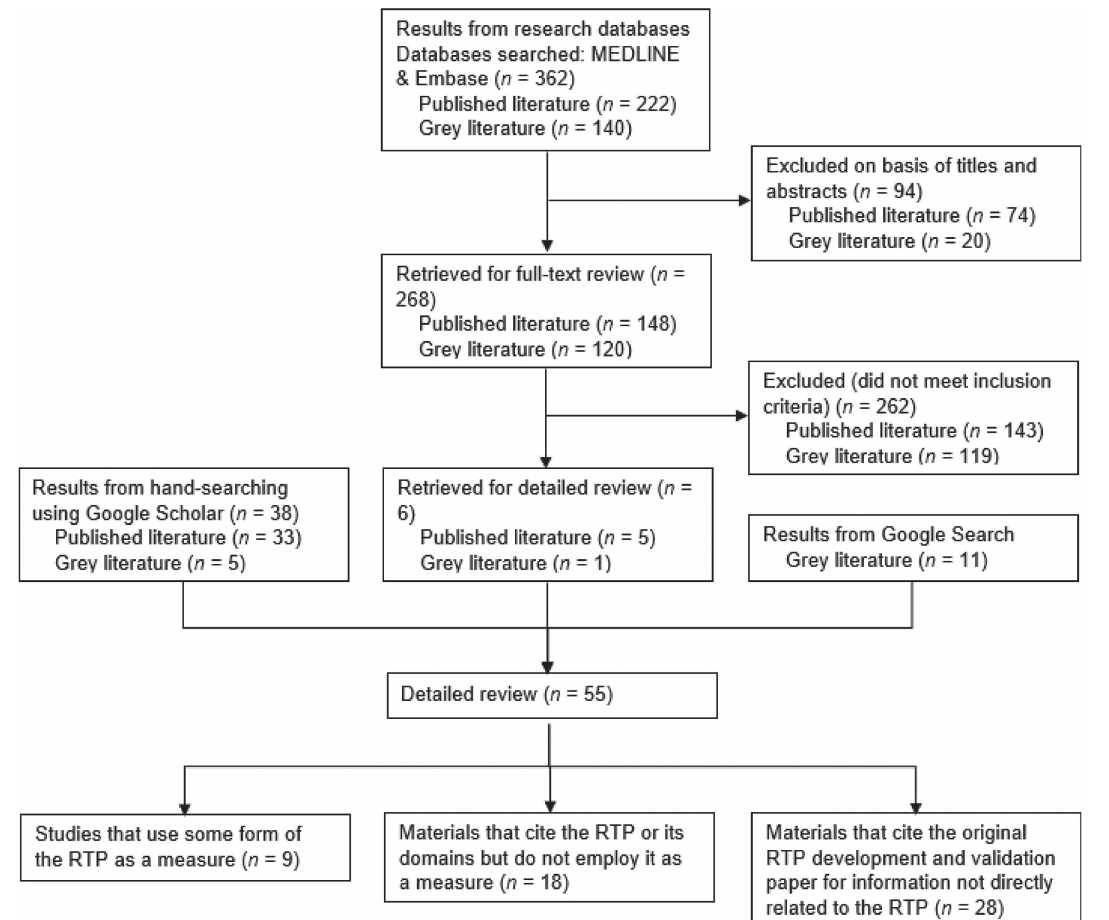
Figure 1: Flowchart of search